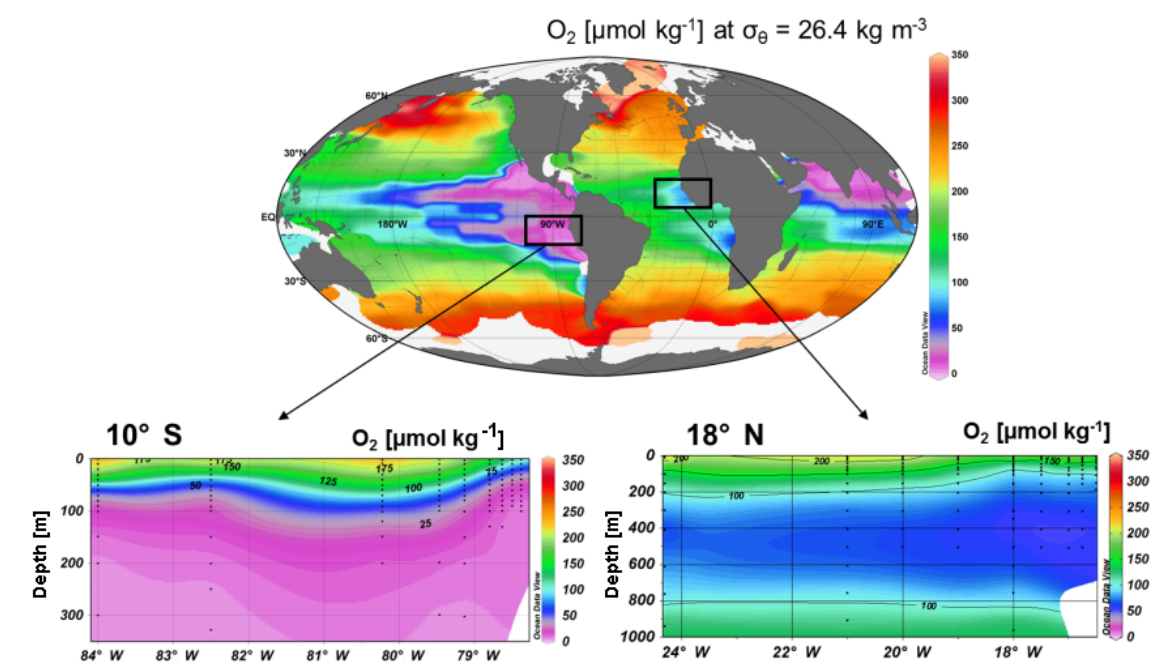
Figure 1. Global distribution of O 2 at σ θ = 26.4kgm − 3 ( ∼ 400m depth): the major regions of low oxygen in the world ocean are all located in the tropical oceans, at shallow to intermediate depths. The area off Peru represents one of the most pronounced OMZs. The investigated areas in the eastern tropical South Pacific and the eastern tropical North Atlantic oceans are marked with black boxes; examples of the O 2 distribution are given along two sections from the coast to the open ocean at 10 ◦ S in the OMZ off Peru and at 18 ◦ N in the eastern tropical North Atlantic; O 2 concentrations are indicated by the color code.